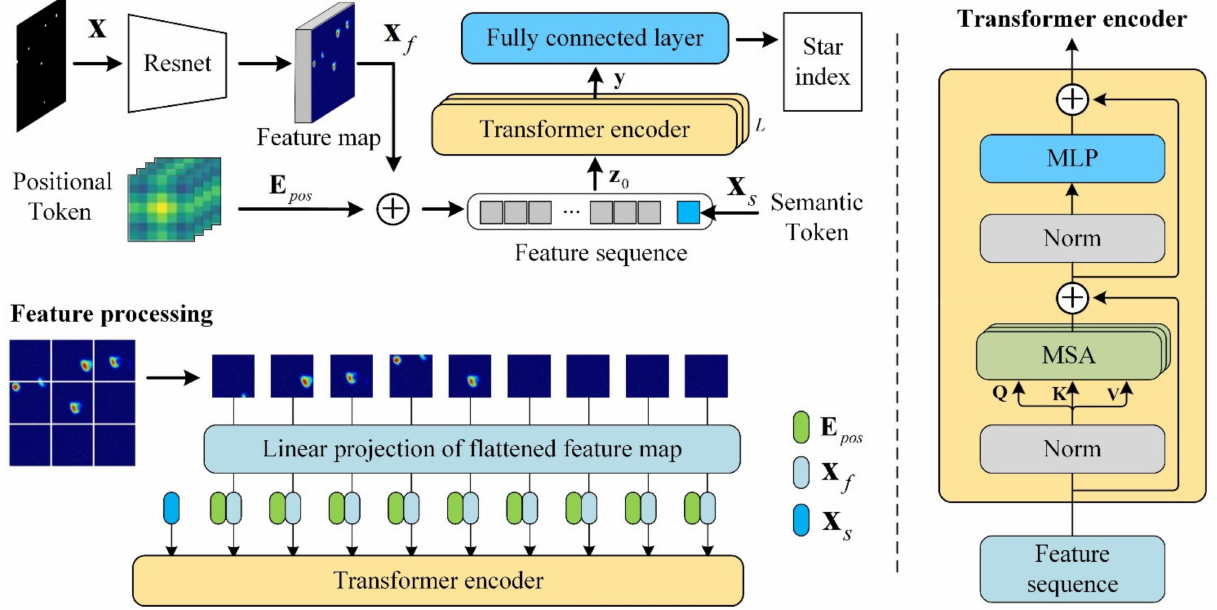
Figure 5. NNs model architecture of the proposed